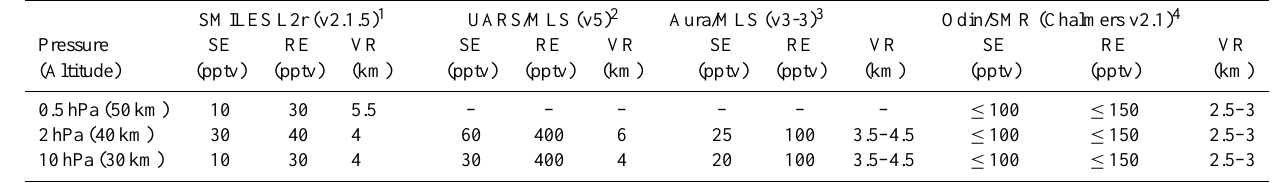
Table 3. Summary of the errors (1- σ ) for a single-scan observation of ClO products observed by SMILES, UARS/MLS, Aura/MLS and Odin/SMR. Systematic error (SE), random error (RE) and vertical resolution (VR) for these instruments are listed. SMILES L2r (v2.1.5) 1